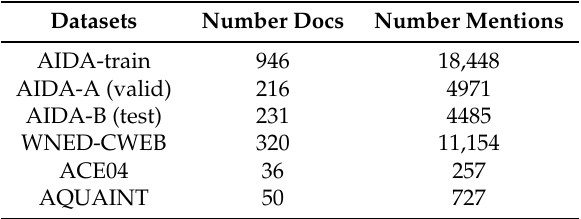
Table 1. Statistics of all the related